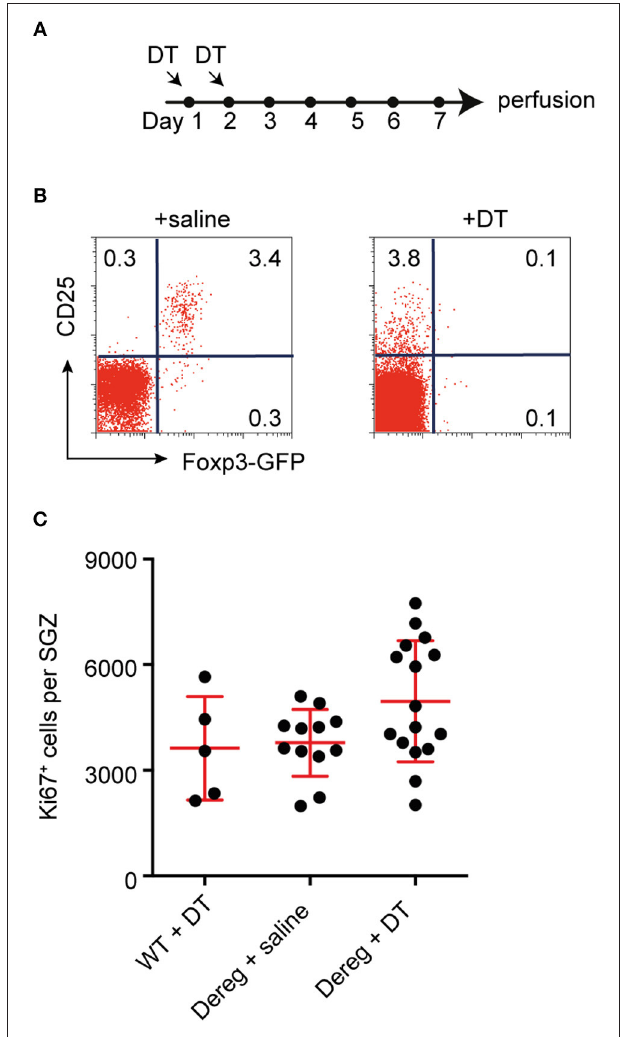
FIGURE 1 | Tregs are not required to maintain baseline levels of hippocampal neurogenesis. (A) Experimental design. (B) Representative dot plots of the frequencies of CD25 + Foxp3-GFP + Treg cells among gated CD4 + T cells in the blood of saline- and DT- treated B6.Dereg mice. (C) Depletion of Tregs had no effect on the number of proliferating (Ki67 + ) precursor cells observed in the hippocampal SGZ. Data were analyzed using a one-way ANOVA with a Dunnett’s post-hoc test. Symbols and horizontal lines indicate individual mice and mean values ± SEM,